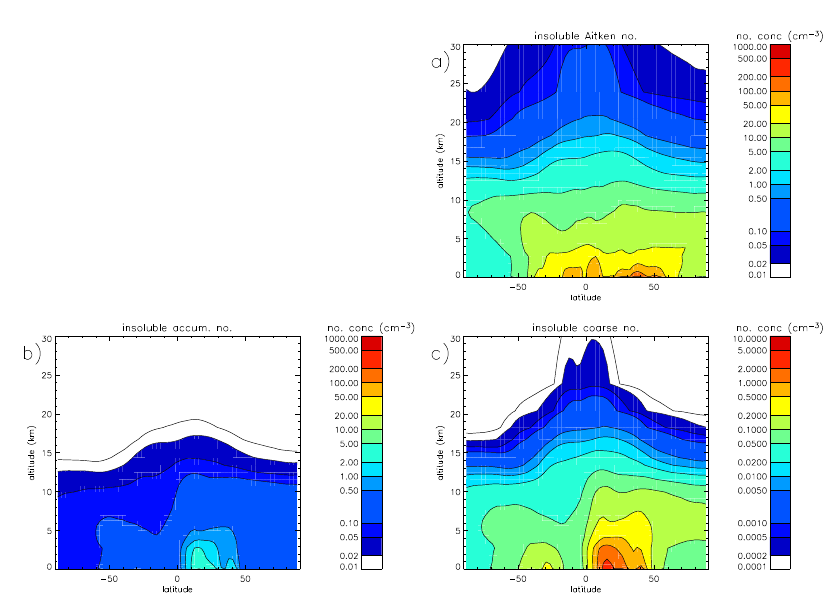
Fig. 15. Latitude-altitude plots of simulated zonal-means of annual-mean particle number concentrations for (a) Aitken-insoluble mode, (b) accumulation-insoluble mode and (c) coarse-insoluble mode.